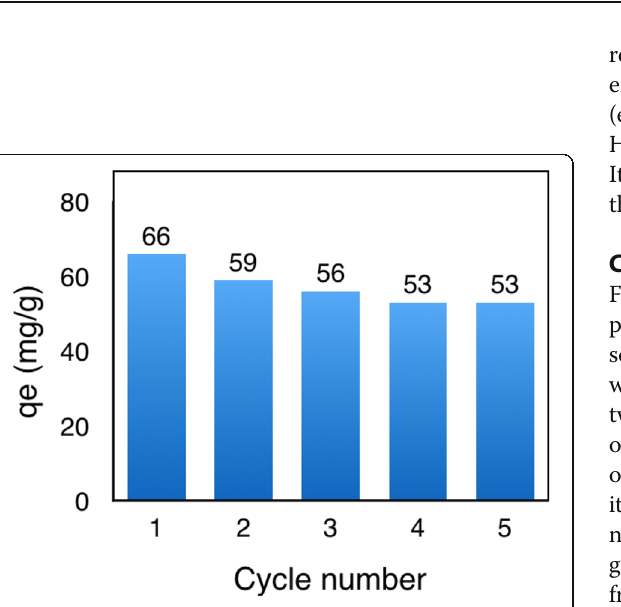
Fig. 5 SEM images and elemental maps of ( a ) Cu-adsorbed (1 – 5) and ( b ) methylene blue (MB)-adsorbed (6 – 10) nGO1-Gel1-LS0.1 composite and their surface and cross-sectional elemental